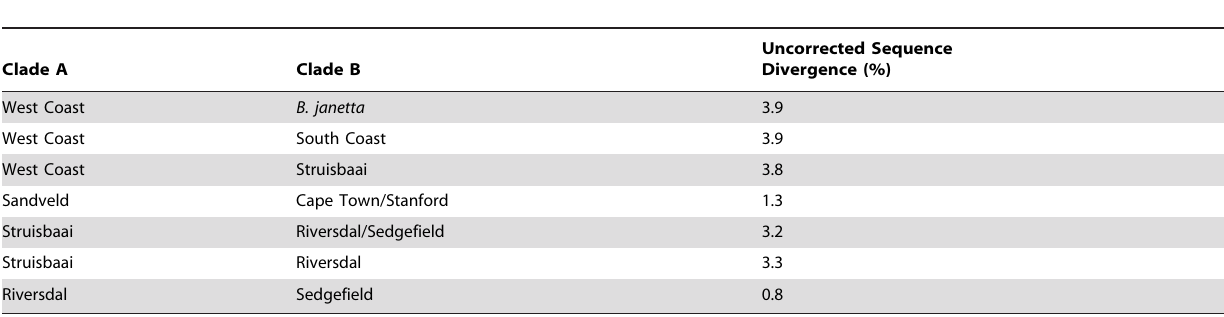
Table 4. Uncorrected sequence divergence between the clades retrieved in the genealogical analyses.